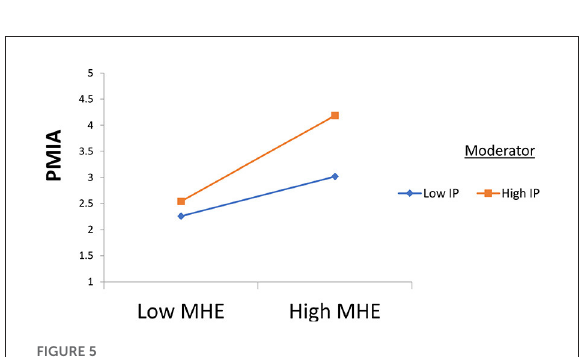
FIGURE5 Moderation 2. MHE, Mental Health Education; IP, Ideological Passion; SWB, College Student’s Wellbeing; PMIA, Politically Motivated Internet